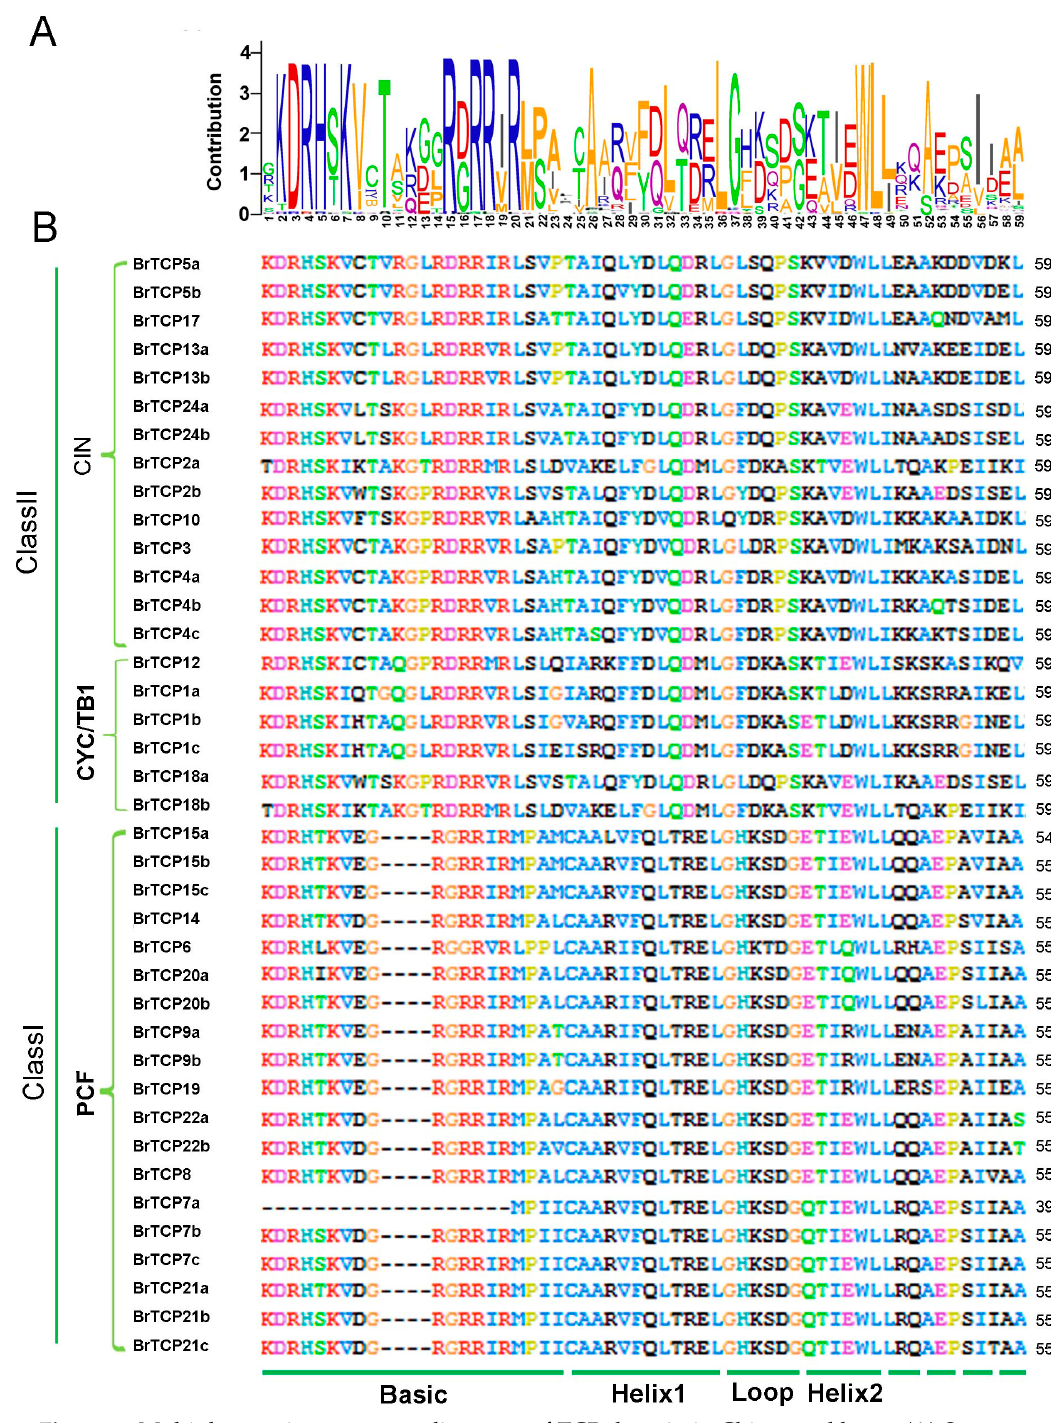
Figure 4. Multiple protein sequences alignment of TCP domain in Chinese cabbage. ( A ) Sequence LOGO of TCPs in Chinese cabbage. The LOGO representation created by Weblogo online software (Berkeley University, CA, USA) based on BrTCP protein sequences; ( B ) Multiple sequence alignment of Chinese cabbage TCP motifs by Clustal X2(University College Dublin, Dublin, Ireland).